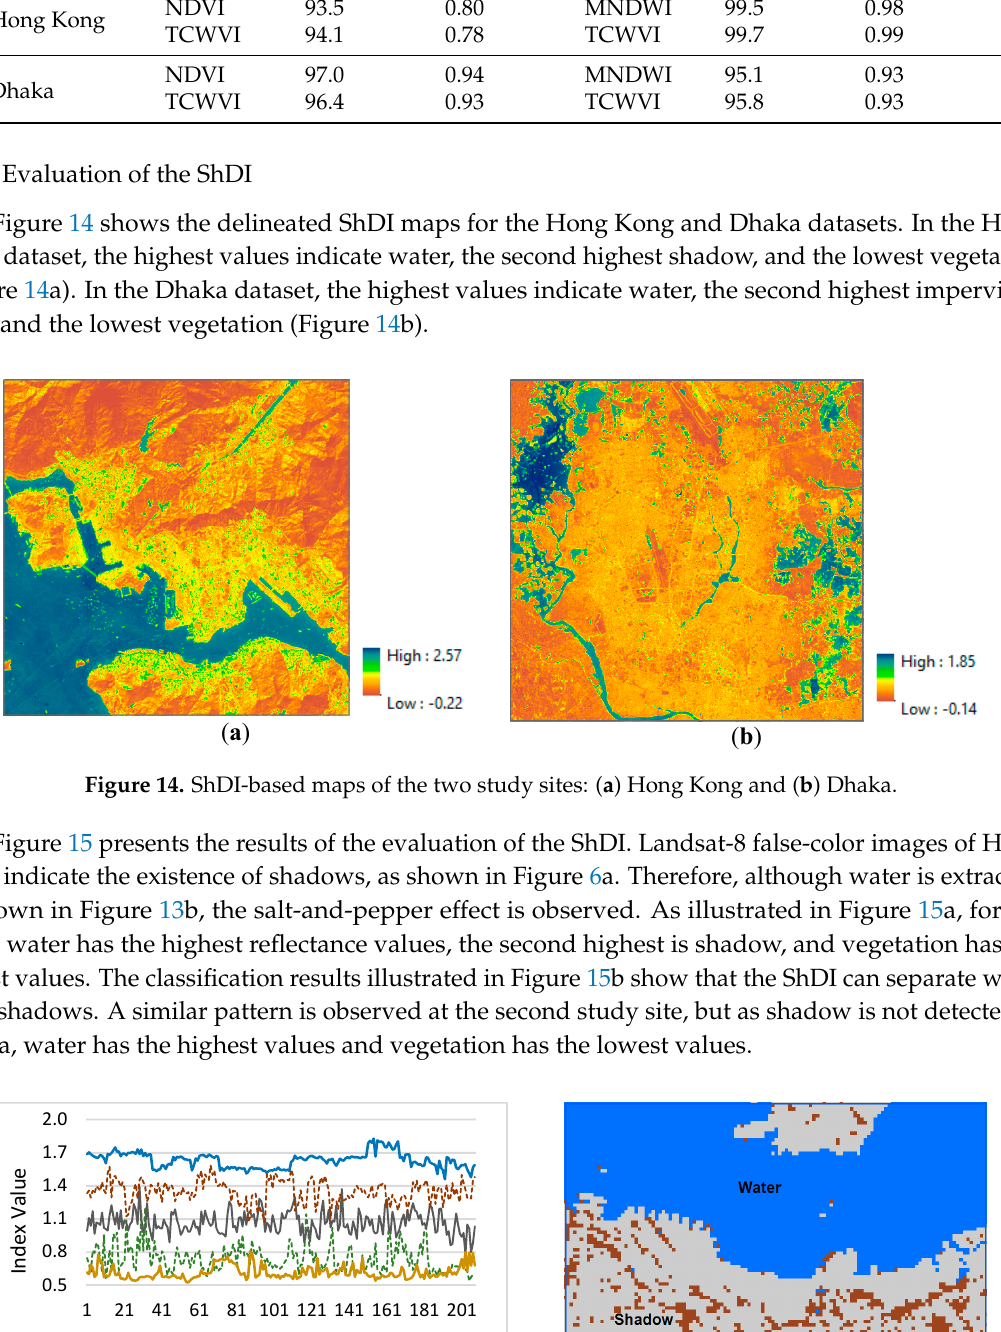
Figure 15. Water and shadow detection using the ShDI in Hong Kong.